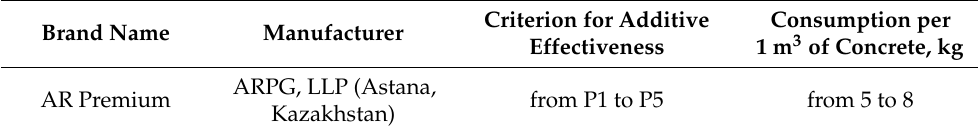
Table 8. Characteristics of polycarboxylate hyperplasticizer [26].